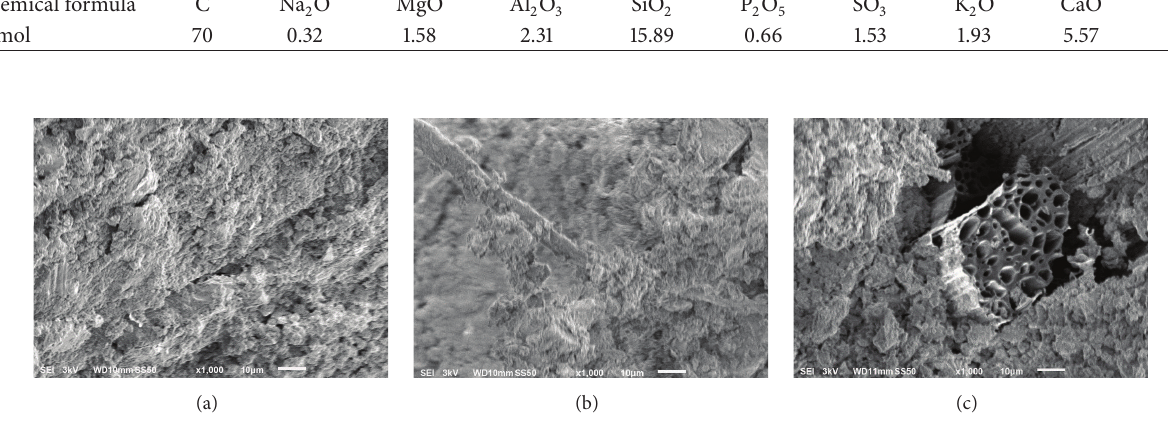
Figure 5: SEM micrographs (1000x) of composite materials: (a) matrix (CPC-30R/H 2 O), (b) M-200-10g, and (c)